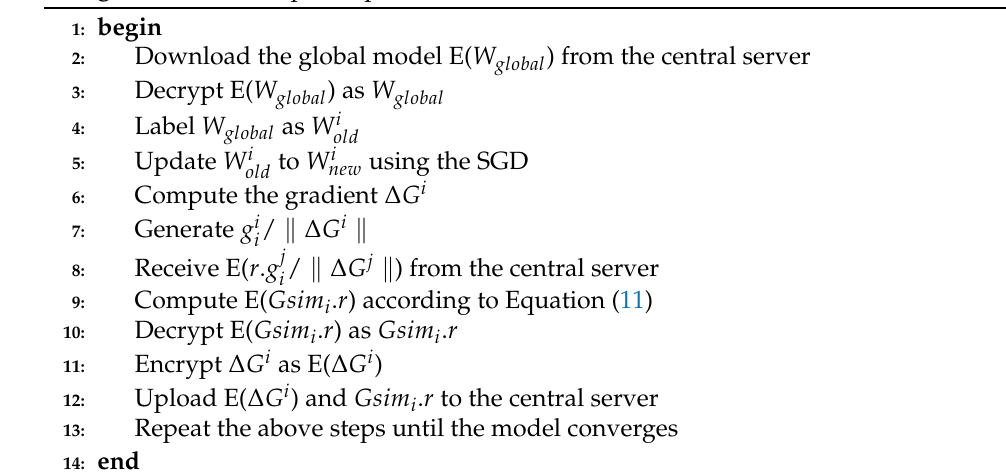
Algorithm 3: Participant’s